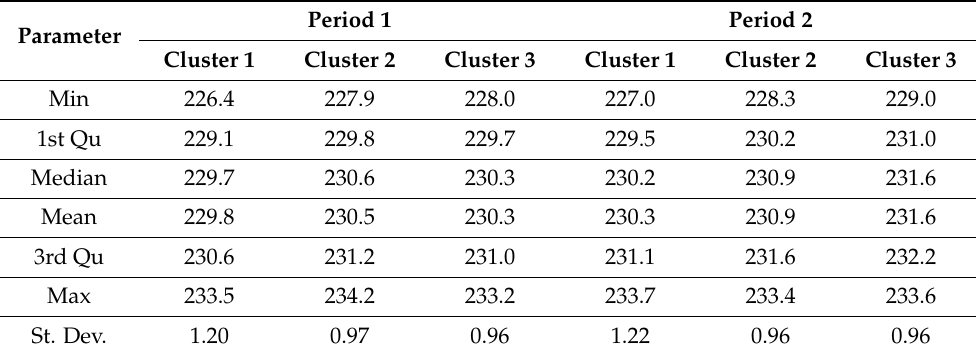
Table 5. Descriptive statistics of the voltage in phase L1 at the tested measuring point.